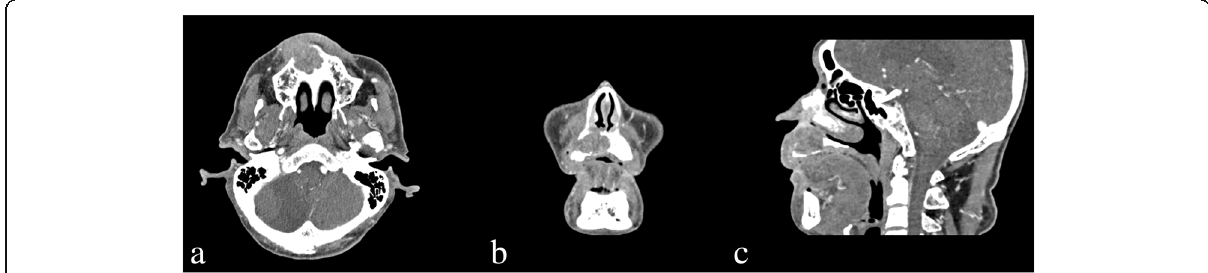
Fig. 3 Facial CT image acquired at the first visit in 2016 showing a dome-shaped radiolucent area in the right maxilla with expansion to the nasal floor and jagged margin of the cortical bone. a Axial view. b Coronal view. c Sagittal